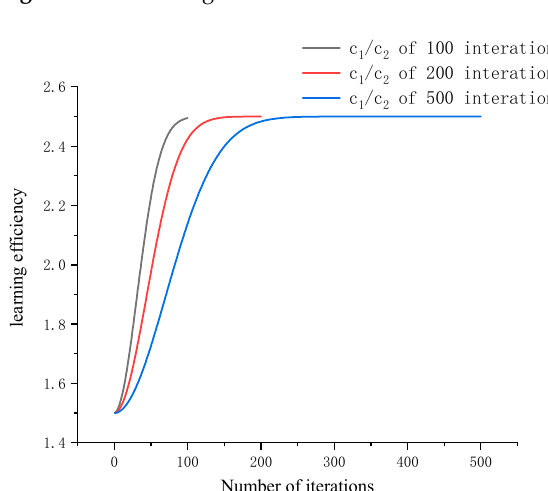
Figure 8. Learning efficiency.